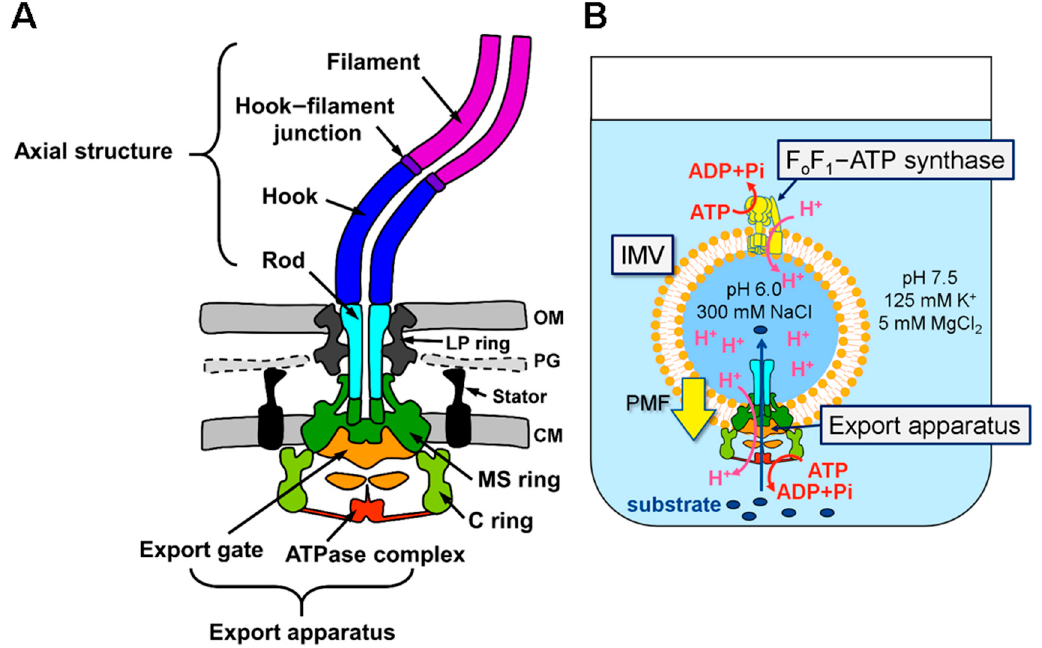
Figure 1. Schematic drawing of the Salmonella flagellum ( A ) and the in vitro transport assay system using the inverted membrane vesicles (IMVs) ( B ). (A) The sub-structures of the Salmonella flagellum are represented in the following colors: the transmembrane export gate, orange; the cytoplasmic ATPase complex, red; the MS-ring, green; the C-ring, light green; the rod, cyan; the hook, blue; the hook-filament junction, purple; the filament, magenta; the LP ring, gray; the stator, black. The core of the export apparatus consists of the export gate and the ATPase complex. The filamentous part composed of the rod, the hook, the hook – filament junction and the filament are called the flagellar axial structure. CM, the cytoplasmic membrane; PG, the peptidoglycan layer; OM, the outer membrane. (B) To apply the initial PMF to the IMVs, the IMVs were filled with 300 mM NaCl at pH 6.0 and suspended in solution with 125 mM K + and 5 mM MgCl 2 at pH 7.5. The export substrates, ATP-Mg 2+ , the FliH 2 /FliI complex, and FliJ were added to the assay mixture. To maintain PMF across the inverted membrane, endogenous F o F 1 -ATP synthase pumps proton into the IMVs by ATP hydrolysis energy. PMF and ATP hydrolysis energy generated by FliI ATPase drives the substrate protein transport into the IMVs.